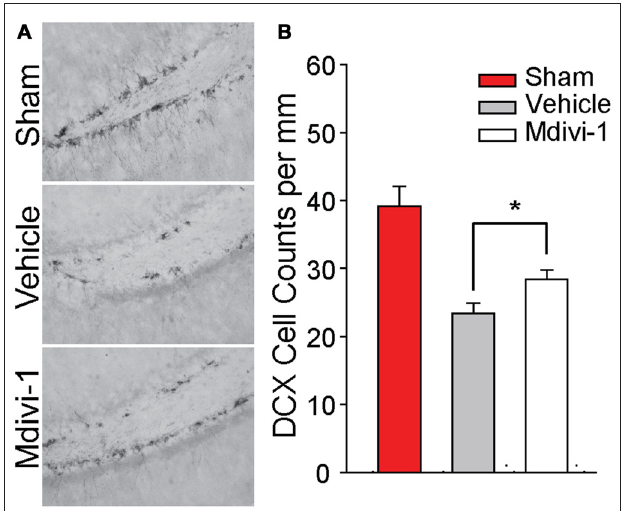
FIGURE 4 | Mdivi-1 treatment reduces loss of newborn neurons in the dentate gyrus of the hippocampus after CCI injury. (A) Representative photomicrographs of Doublecortin (DCX) positive staining in the dentate gyrus of the ipsilateral hippocampus in a sham and 24 h post-injury animals (vehicle-treated and Mdivi-1 treated). (B) Quantification of DCX+ cells in the ipsilateral and contralateral dentate gyrus for each group revealed that animals treated with Mdivi-1 had increased DCX+ cells in the ipsilateral hippocampus compared to vehicle-treated controls, suggesting reduced loss of newly born neurons. Data are presented as the mean ± SEM. ∗ p < 0.05.